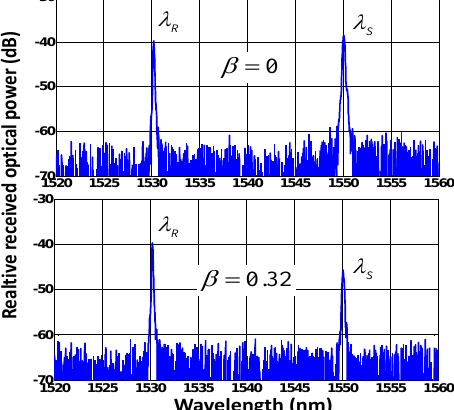
Figure 3. Optical spectrum of both the reference ( ) and sensing ( ) channels before being sliced through the CWDM demultiplexer device, at different